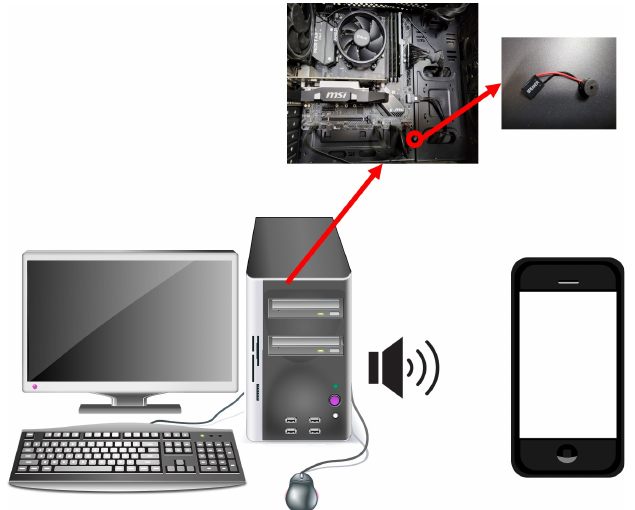
Figure 1. Diagram that shows the overall process of the